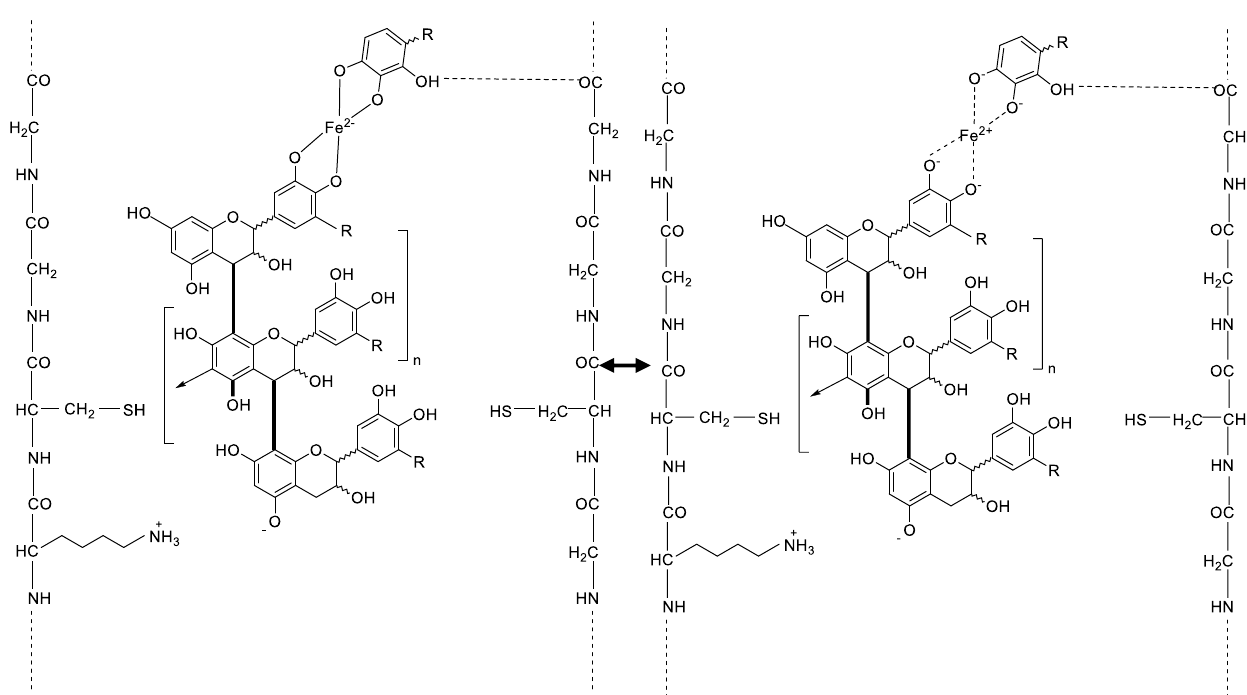
Figure 7. Possible interactions between hair fibers and flavonol compounds of matcha and the mesomeric effect of iron(II)-lactate where R=-H, -CH, or -OH.